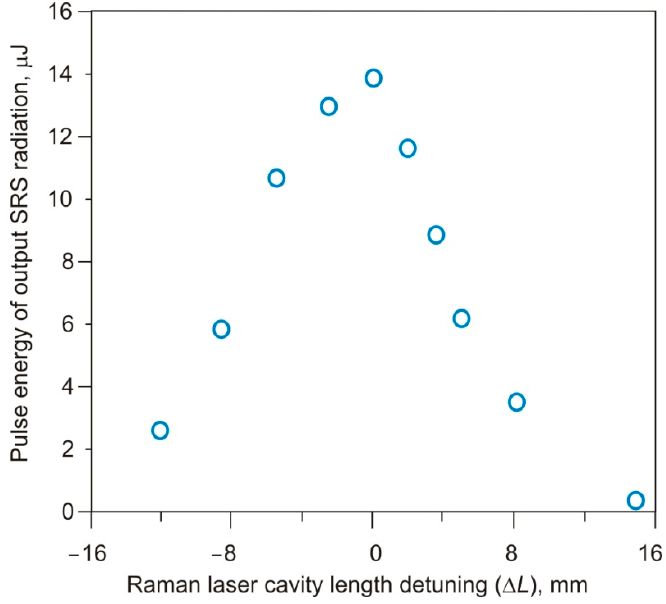
Figure 3. Detuning of the Raman laser cavity length.